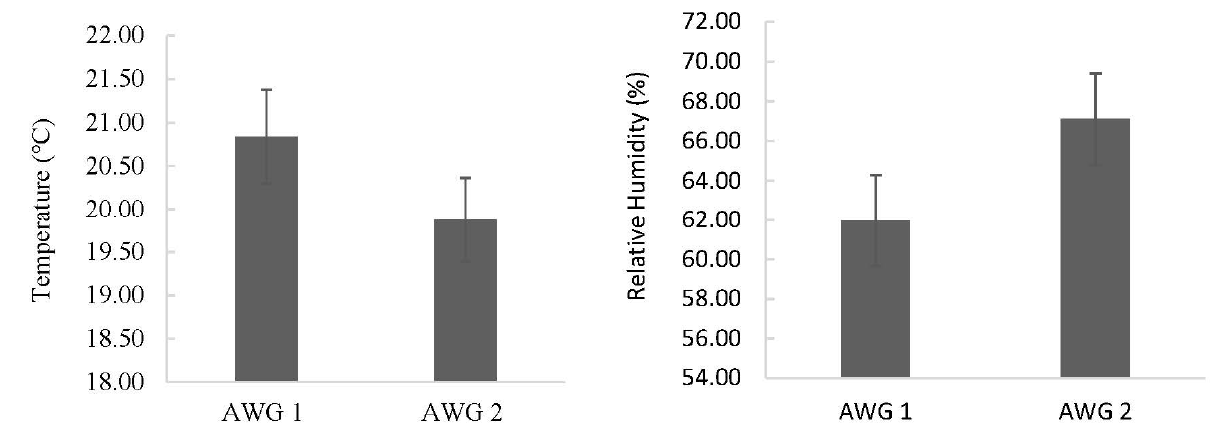
Figure 9. Temperature and RH of AWGs operating under pristine and modified conditions.